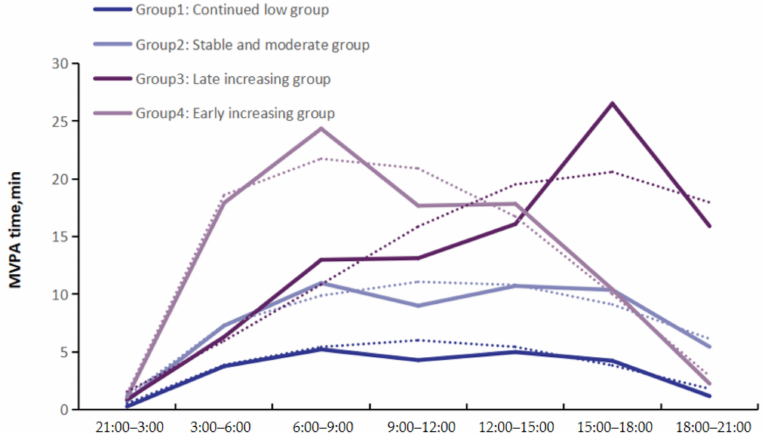
Figure 1. Trajectory groups of physical activity patterns in this study. Solid horizontal lines indicate the trajectory of the measured value for MVPA time (min). Dashed lines depict the predict trajectory for the four groups. Table 1. Model-adequacy criteria of the trajectory analysis. Trajectory